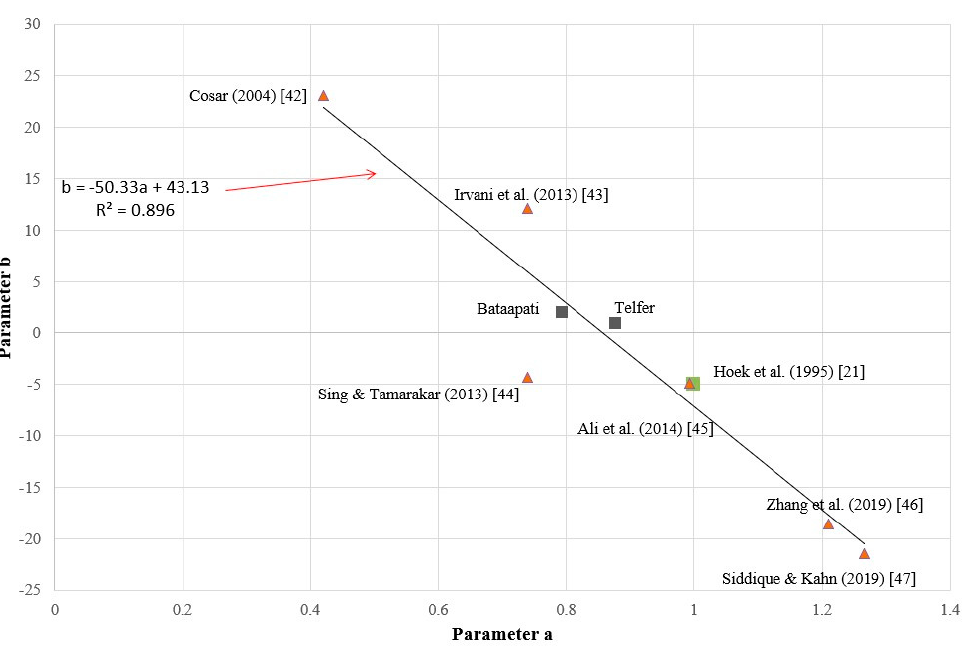
Figure 7. Correlation between Chart GSI and RMR values in Bátaapáti project ( a ), and in Telfer project ( b ).